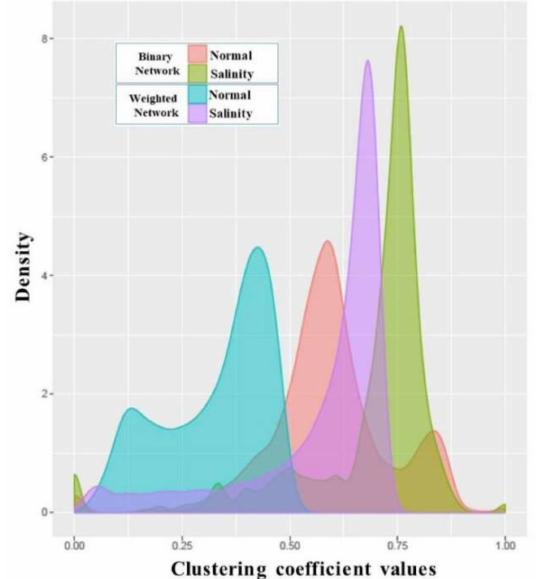
Figure 6. Clustering coefficient distributions of normal-state and salinity-state networks. Pink and green plots are the clustering coefficient distributions of the binary networks for normal and salinity states, respectively. The blue and purple plots are the clustering coefficient distributions of the weighted signed networks for the normal and salinity